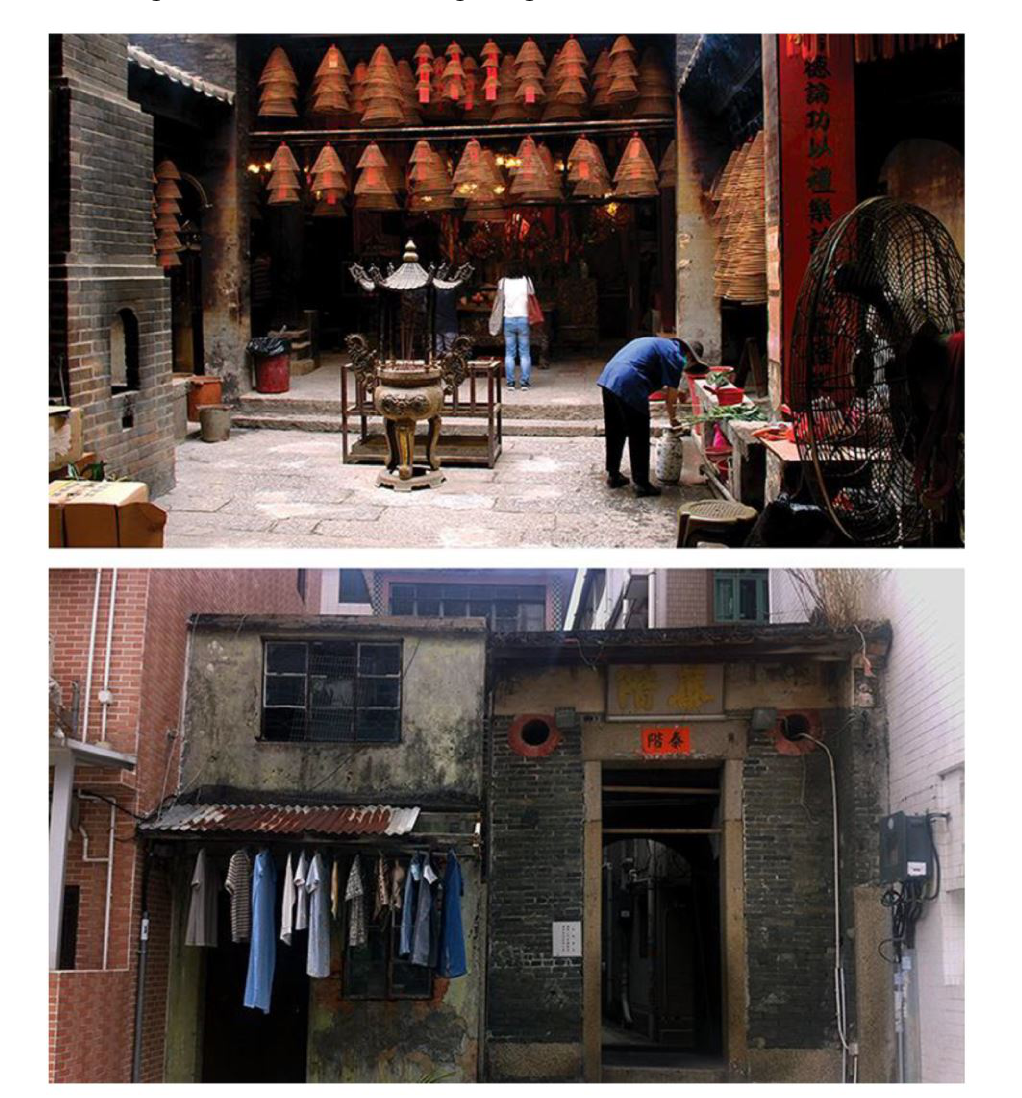
Figure 1. Act-in-field in Hong Kong (Source: Louise Janvier,